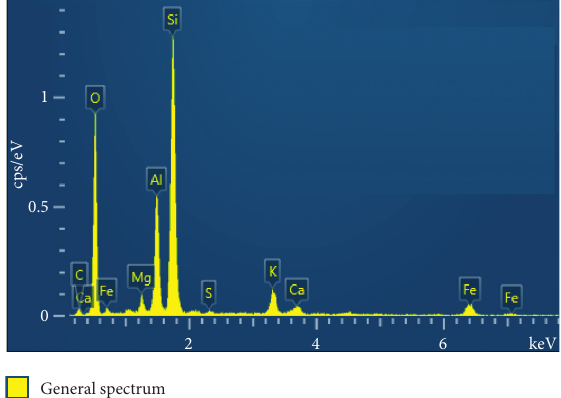
Figure 3: The energy dispersive X-ray (EDX) test results of the slurry.